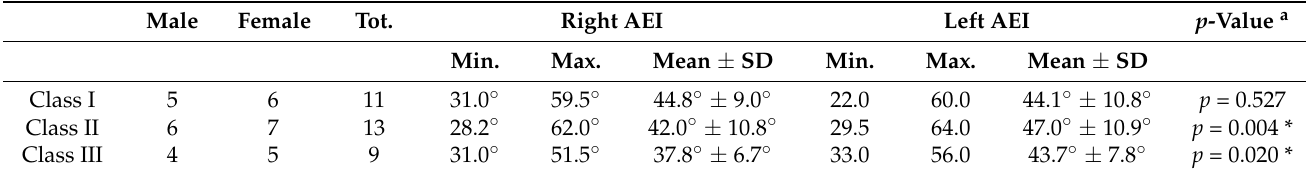
Table 2. Articular Eminence Inclination (AEI) values in the right and left sides of the three groups. Male Female Tot. Right AEI Left AEI p -Value a Min. Max. Mean ± SD Min. Max. Mean ± SD